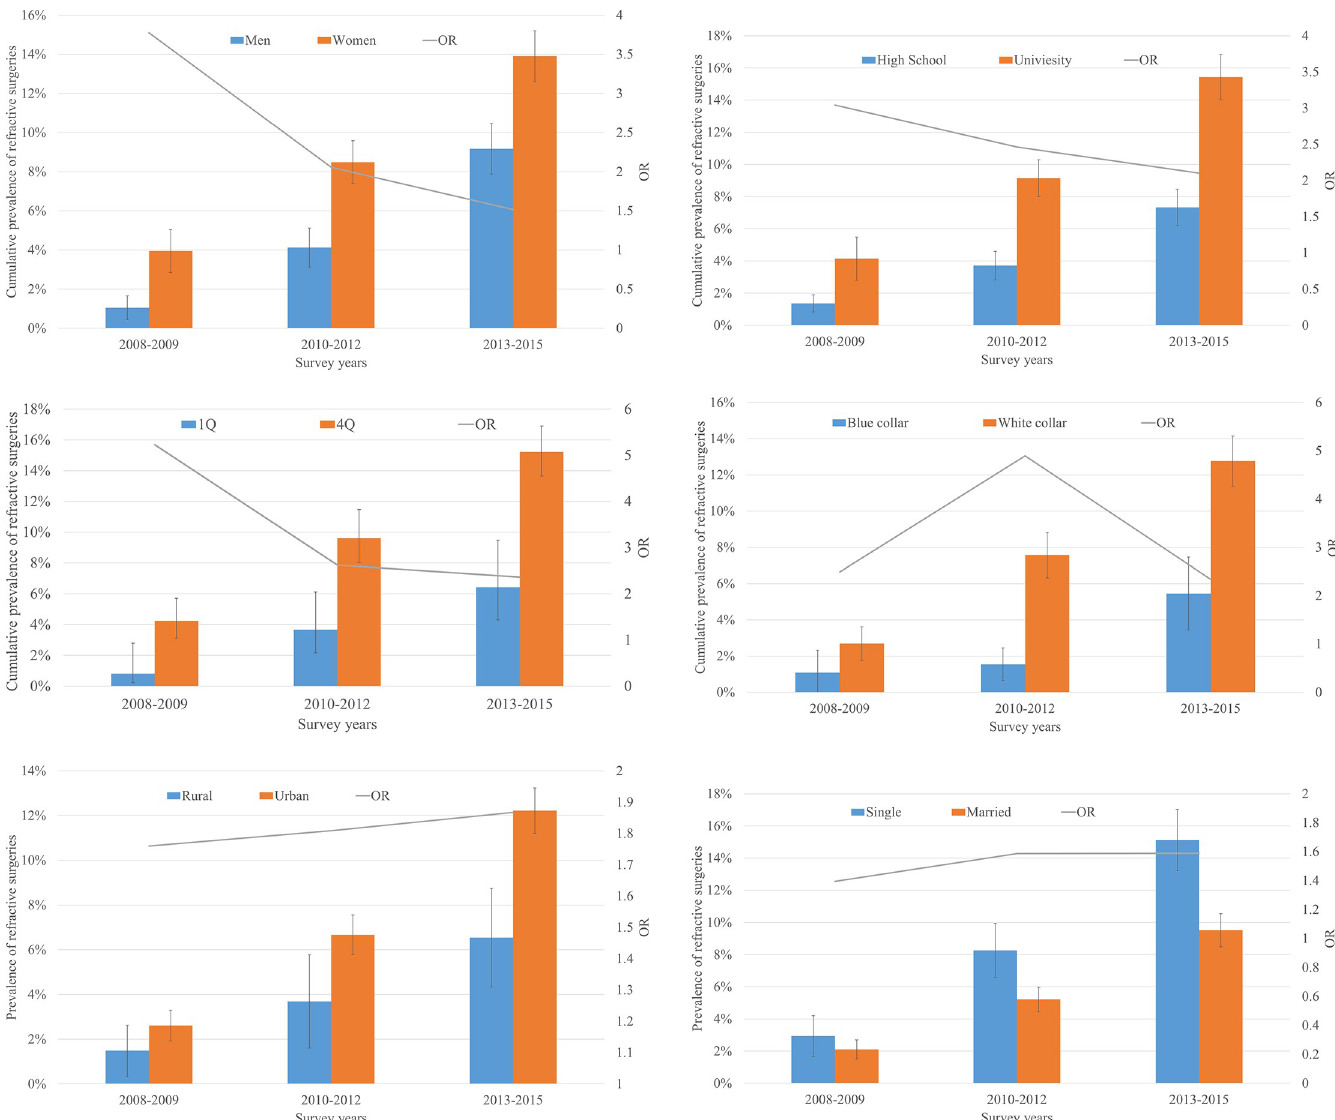
Fig 2. Comparison of prevalence of refractive surgeries divided by sub-groups. Cumulative prevalence of refractive surgeries showed that gaps between (A) genders (men/women), (B) educational level attainment (high school or less/college or higher), (C) household monthly income level (lowest/highest quartile), and (D) job style (blue collar/white collar) were decreasing over the time. When it comes to (E) residential areas (rural/urban) and (F) marital status, the gaps were widening over the time, but the differences of the gaps were decreasing. Abbreviations: OR = Odds ratio; 1Q = lowest quartile; 4Q = highest quartile.